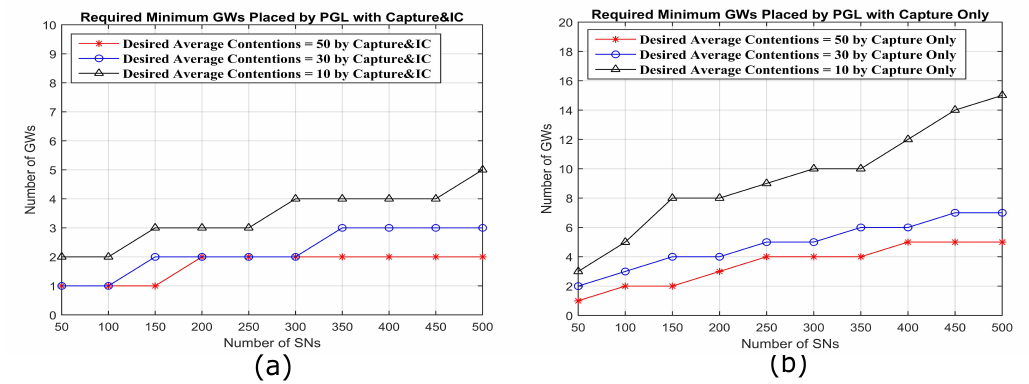
Figure 16. To maintain a desired minimum average contention, the number of GWs placed by the PGL algorithm, both with capture and IC and capture only, will grow with the increasing number of SNs. However, the required minimum number of GWs placed by PGL with capture and IC will be less than that with capture